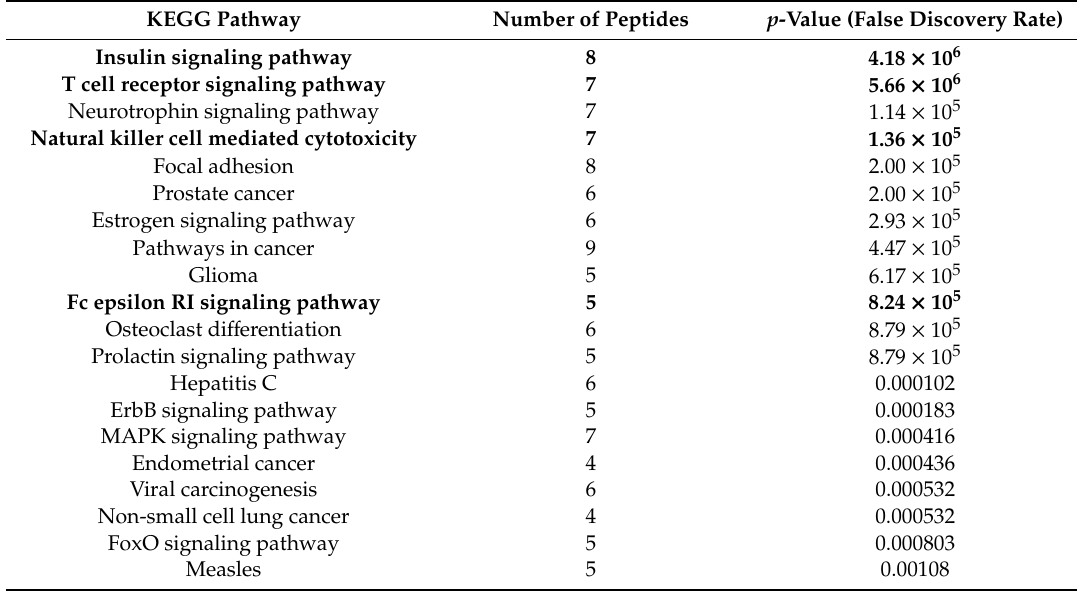
Table 8. Top 20 KEGG pathways enriched from unique peptides in the C. perfringens challenge jejunum (compared to postbiotic and postbiotic plus C. perfringens challenge).